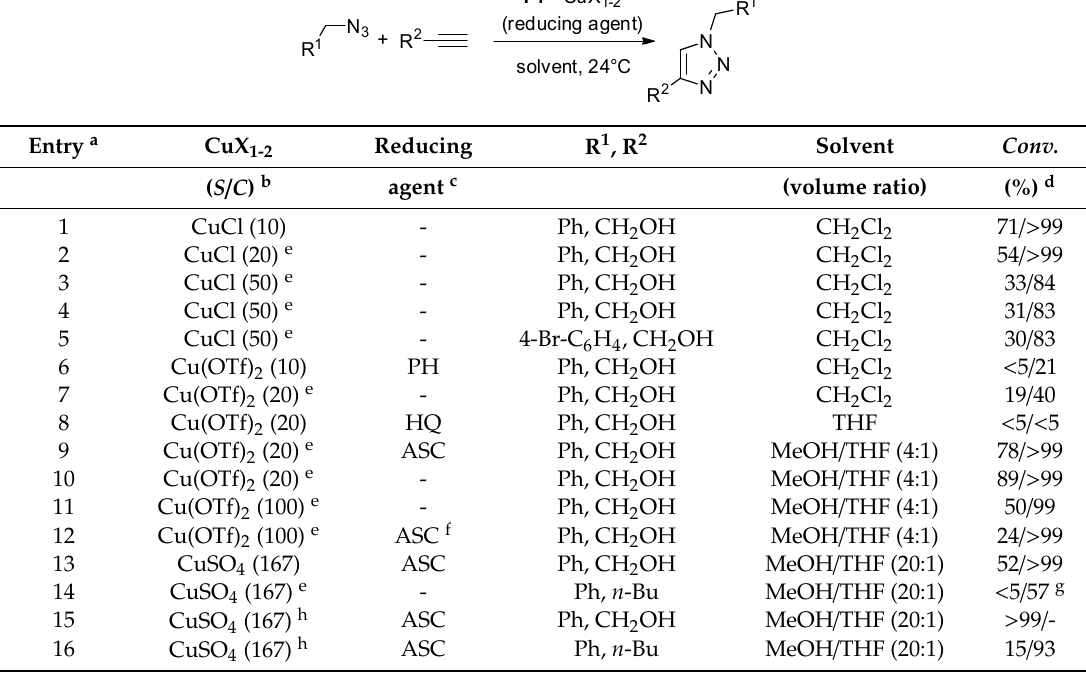
Table 1. Copper-catalyzed azide-alkyne cycloaddition reaction (CuAAC) runs in batch with P7 loaded with Cu(I) or Cu(II) salts. N 3 + R